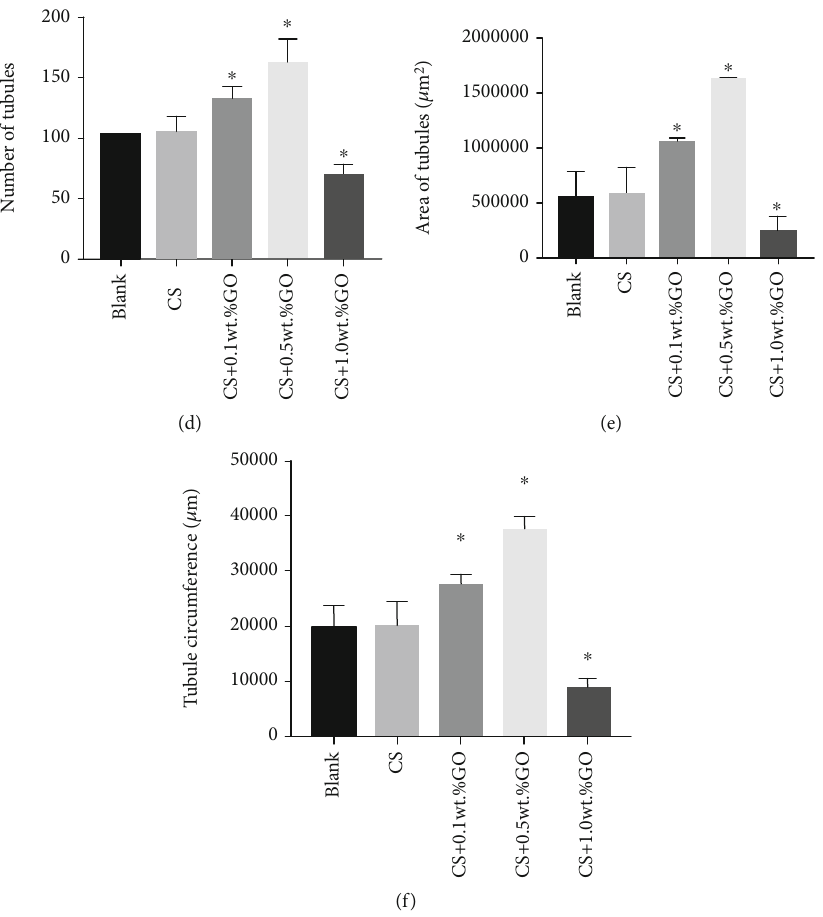
Figure 5: E ff ect of CS/GO hydrogel sca ff olds on the proliferation and angiogenesis of EPCs. (a) Proliferation level of cells in each group determined by the CCK-8 assay. (b) Cytotoxicity of hydrogel sca ff olds in each group evaluated by the LDH assay. (c – f) Angiogenesis ability of cells in each group determined using tube formation. ∗ P < 0 : 05